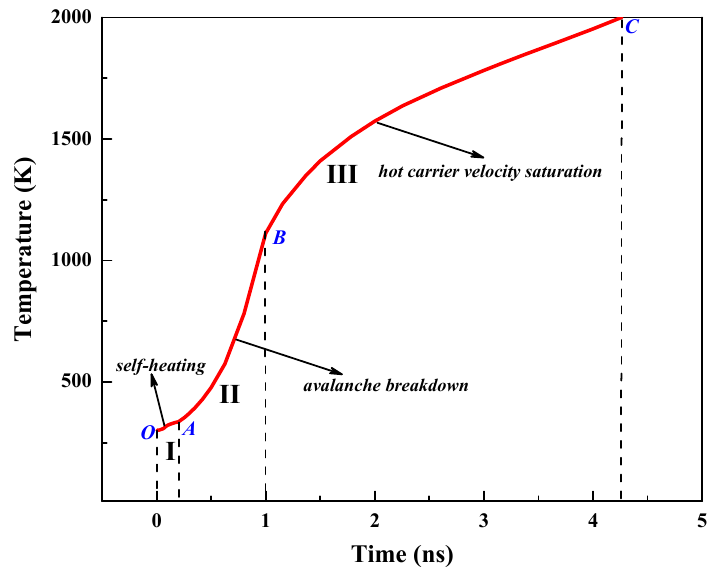
Figure 3. Variation in the maximum temperature ( T max ) inside the GaN HEMT with injection time. Figures 4 and 5 show the internal electric field distribution and current density distribution of the GaN HEMT at the high-power injection times of 0 ns, 0.1 ns, 0.5 ns and 2 ns,